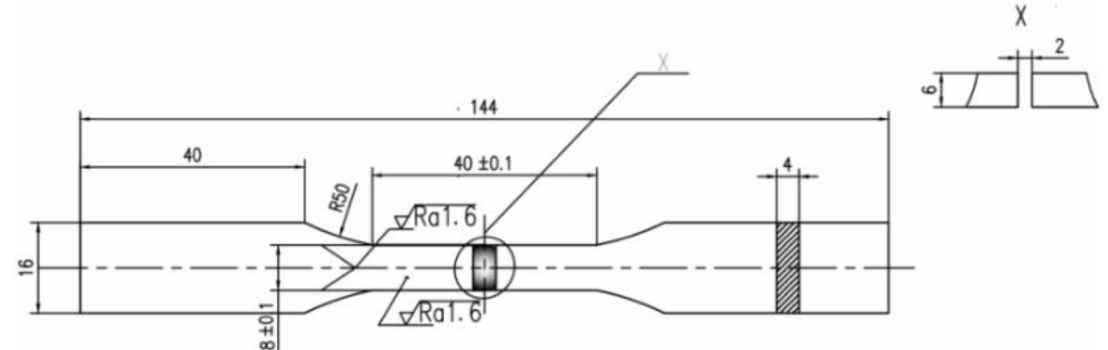
Figure 1. Dimensions (in mm) of the welded